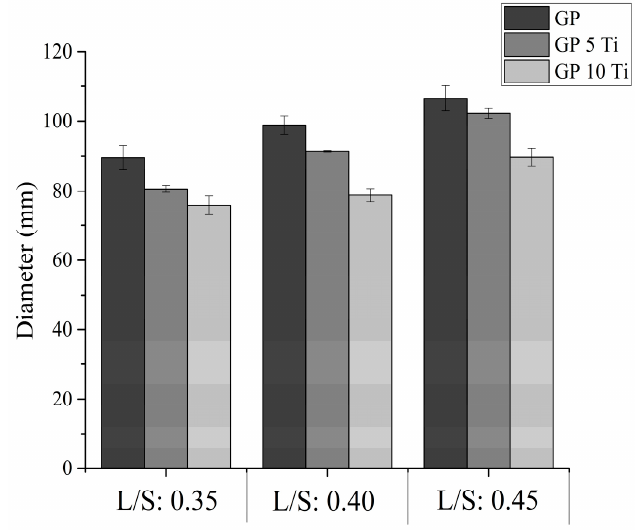
Figure 4. Fluidity of the various systems evaluated.